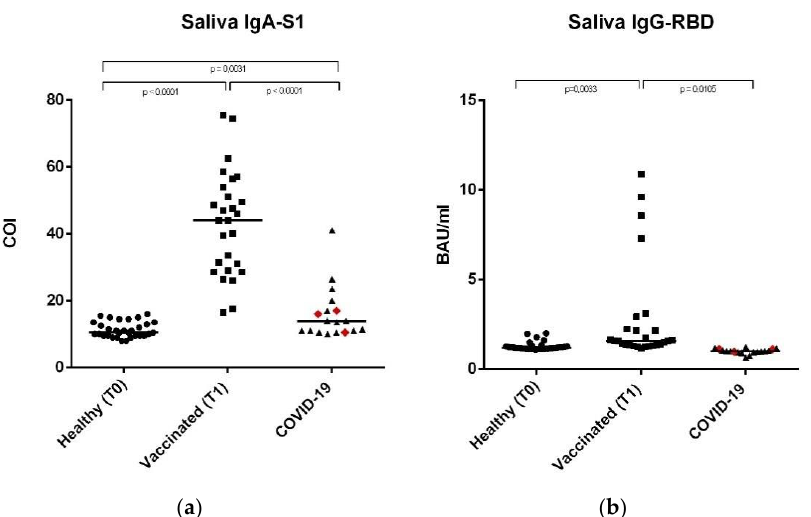
Figure 2. Anti-SARS-CoV-2 IgA-S1 and anti-SARS-CoV-2 IgG-RBD in saliva samples. ( a ) Saliva sam-